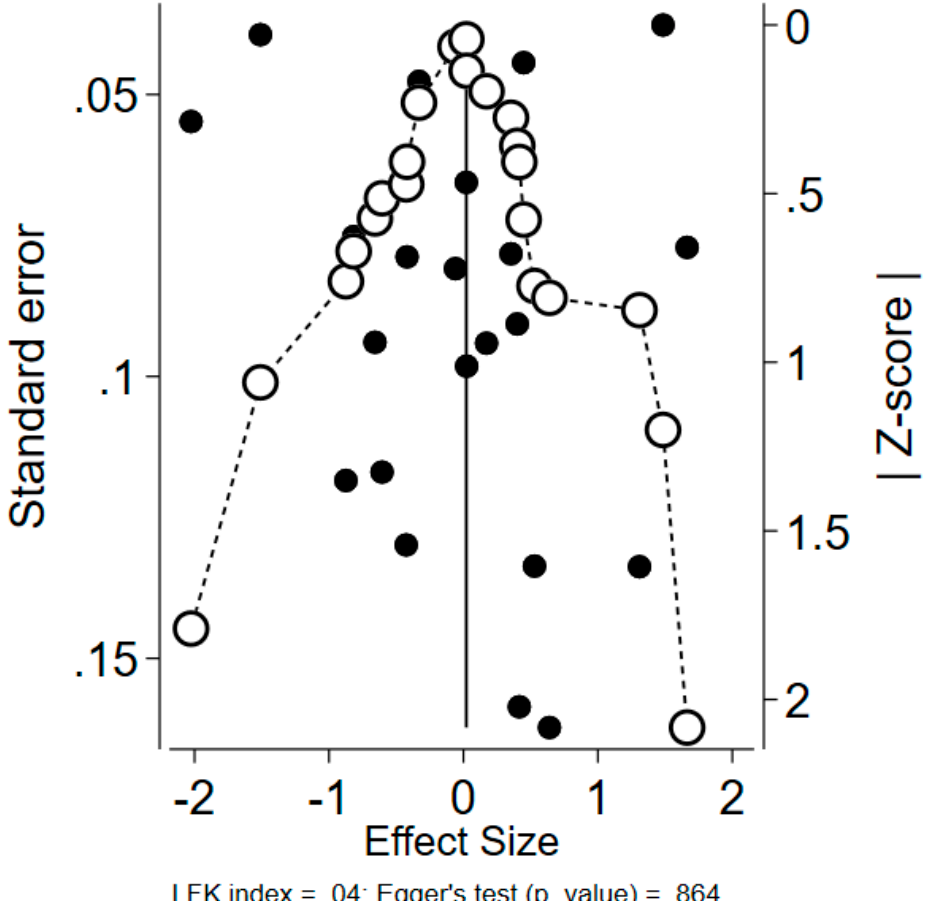
Figure 4. DOI plot with LFK index = 0.04, along with the funnel plot and Egger’s test ( p -value = 0.864).